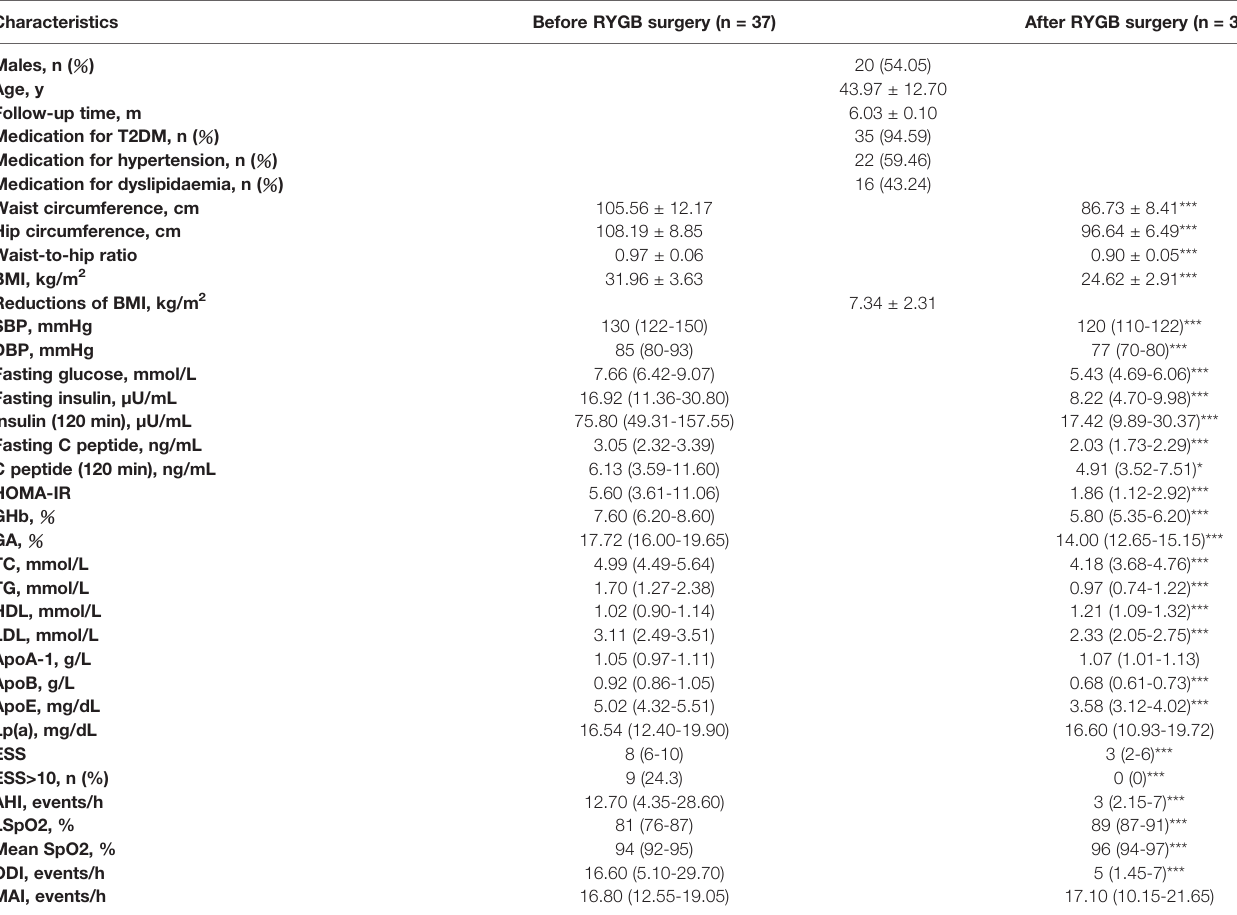
TABLE 1 | Anthropometric and clinical characteristics of the enrolled patients. Characteristics Before RYGB surgery (n = 37) After RYGB surgery (n =